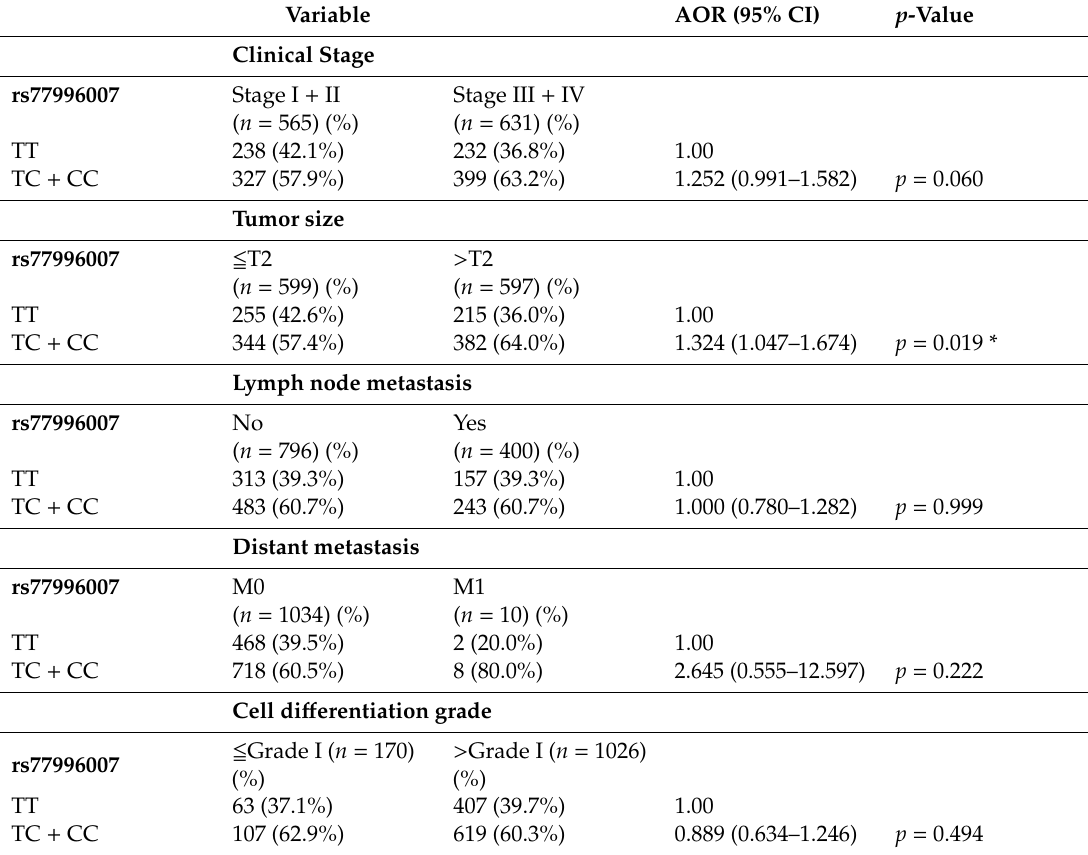
Table 4. The adjusted odds ratio (AOR) and 95% confidence intervals (CI) of clinical statuses